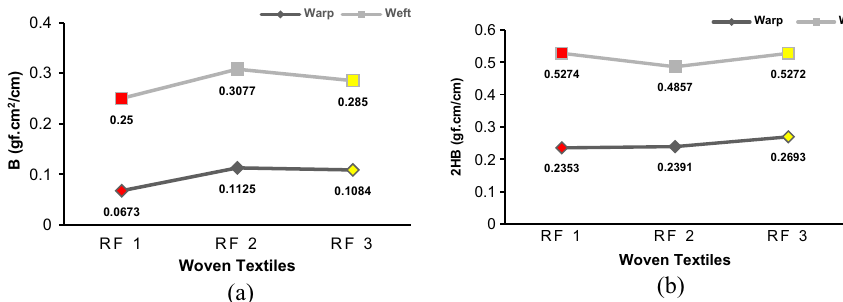
Fig. 9 a Bending rigidity—B (gf.cm 2 /cm) and b bending hysteresis—2HB (gf.cm/cm). RF Reflective fabric